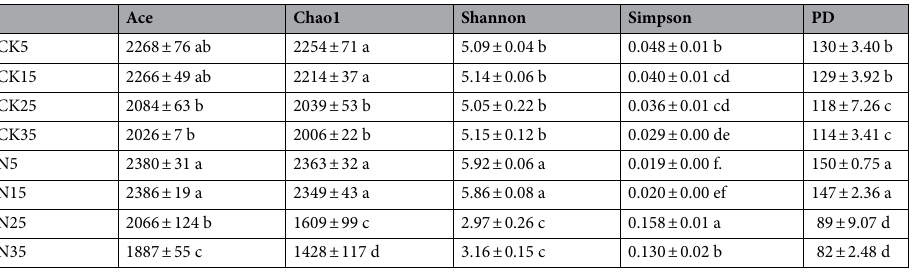
Table 1. Bacterial α-diversity under different incubation temperatures. All data are presented as mean ± standard deviation (n = 3). CK, soil samples with no nitrogen application; N, soil samples with nitrogen application. Differences in bacterial alpha diversity among different treatments was analyzed using one-way ANOVA. Data followed by different letters indicate a significant difference ( P < 0.05).